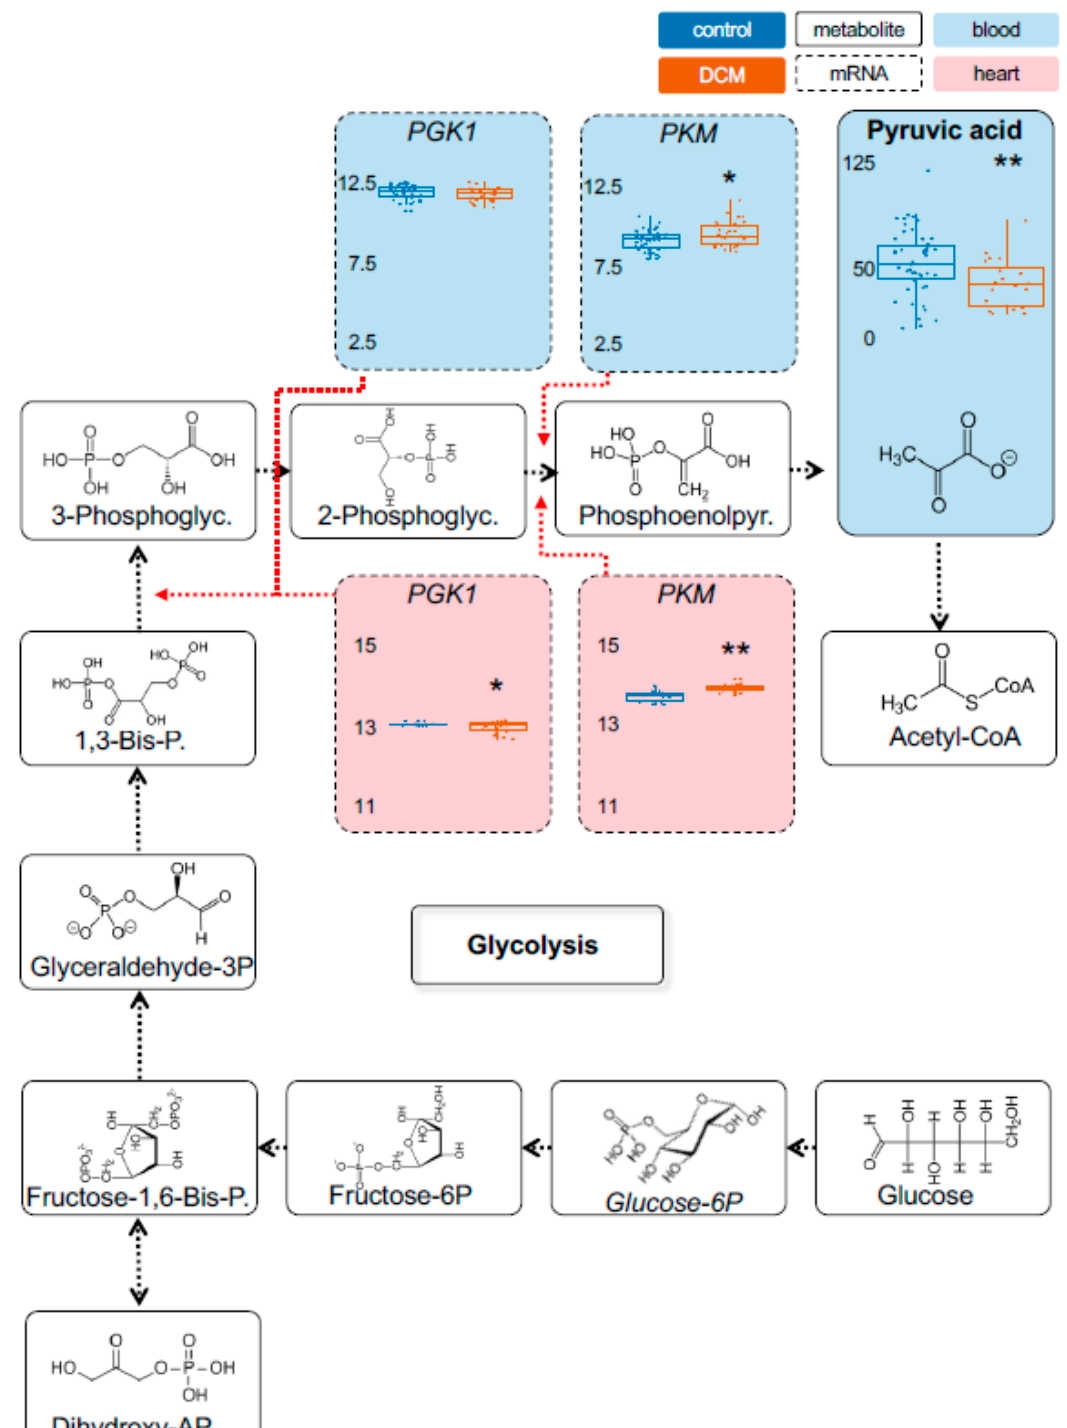
Figure 1. Detection of metabolic changes in glycolysis in heart failure (HF) patients. Control (CTRL) samples are depicted in blue. Values of the Dilated Cardiomyopathy (DCM) cohort are colored orange. Significance values are indicated. Boxes with dashed lines indicate mRNA expression and with full lines metabolite levels in serum (light blue shading) and left-ventricular heart tissue (pale red shading). As shown, PKM expression is upregulated in blood cells and myocardial tissue, while the resulting metabolite pyruvic acid was not significantly altered. Metabolite concentrations are shown as [µM]. RNAseq expression is given as (rlog-)normalized read counts. *: p < 0.05; **: p < 0.01. PGK1 = phosphoglycerate kinase 1; PKM = pyruvate